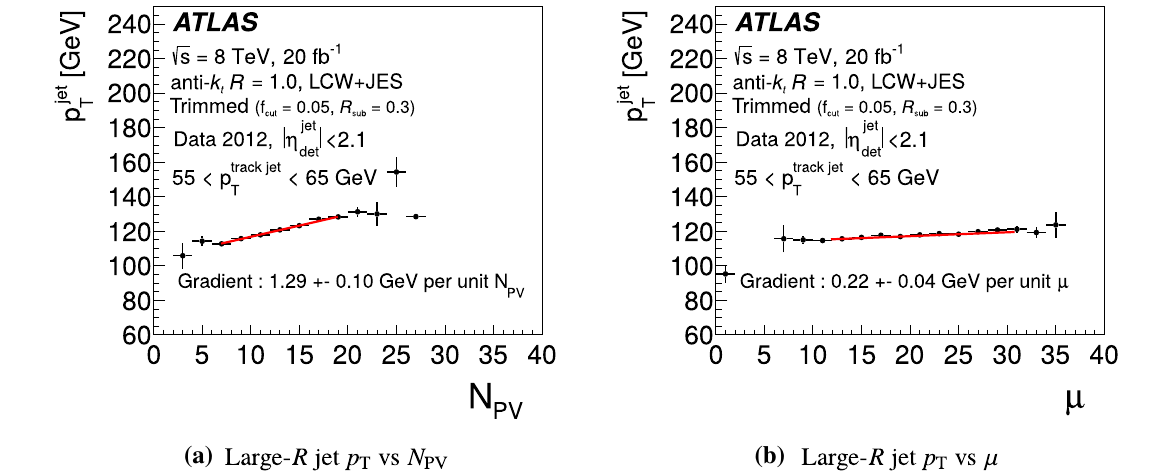
Fig. 31 Large- R jet p T as a function of a N PV in γ +jet events with are linear fits. The markers show data with error bars corresponding to 20 < μ < 22, and as a function of b μ in events with 10 < N PV < 12. the statistical uncertainties. The lowest point shown in b corresponds < 65 GeV. The lines to special data-taking conditions, and is thus not expected to match the The p trackjet is required to be within 55 < p trackjet T T other points on the